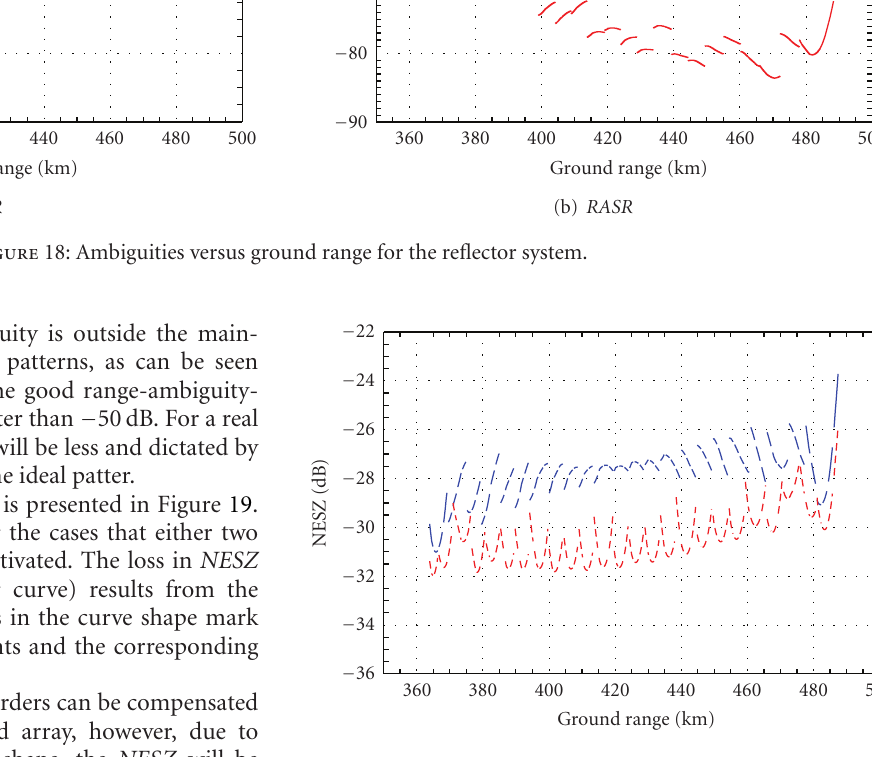
Figure 19: The noise-equivalent sigma zero of the reflector system versus ground range for two (solid curve) and four (dashed curve) active feed